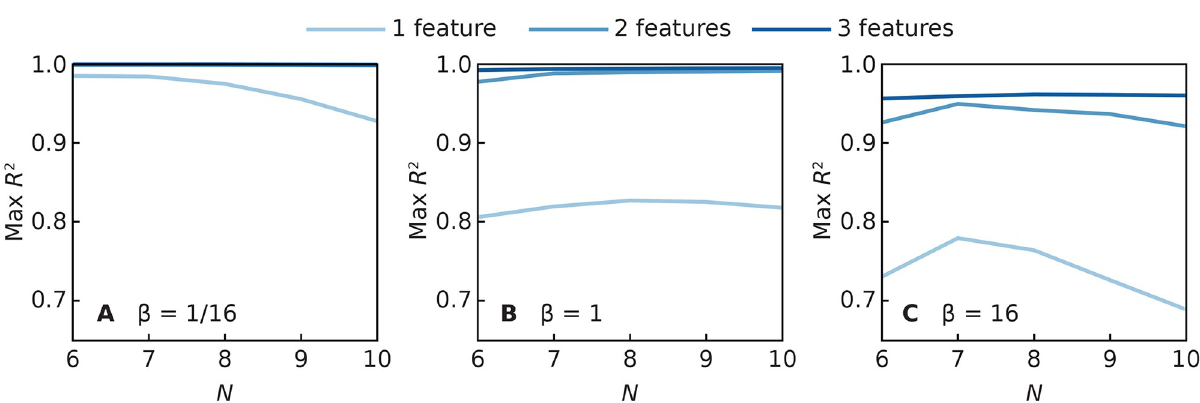
Fig 12. Size scaling of the best predictability for one, two and three features. The three panels represent less (A), medium (B) and more (C) contagious diseases.